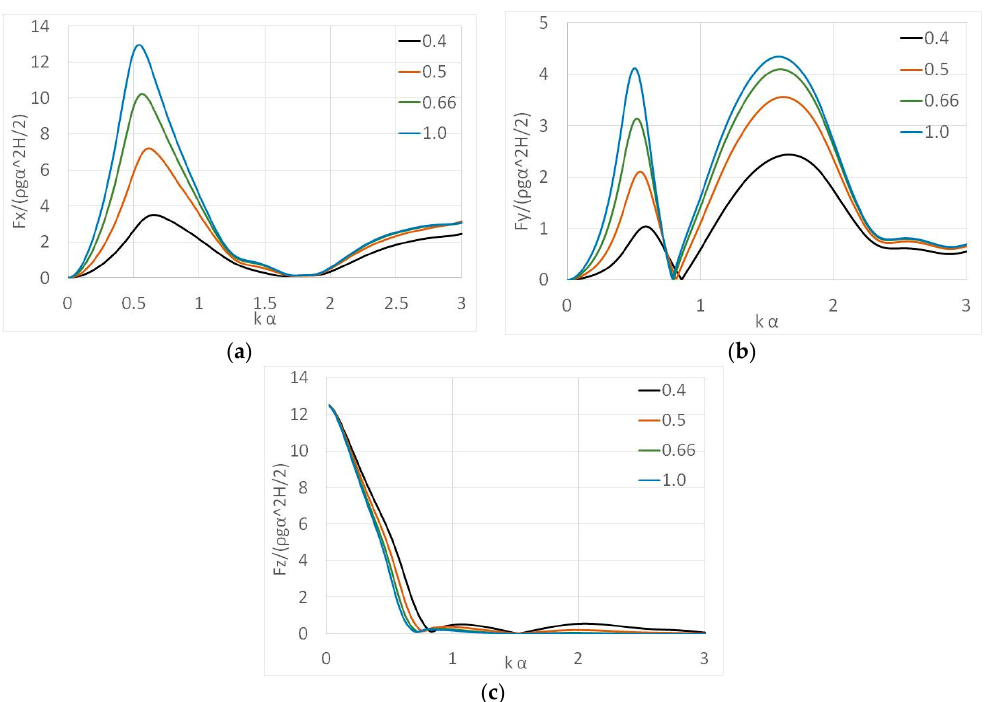
Figure 7. Exciting forces on a floating cylindrical floater placed in front of an orthogonally shaped (right angle) breakwater using the method of images for a /h = 0.4; 0.5; 0.66; 1.0: ( a ) Horizontal-exciting force on x -axis; ( b ) Horizontal-exciting force on y -axis; ( c ) Vertical-exciting force on z -axis.